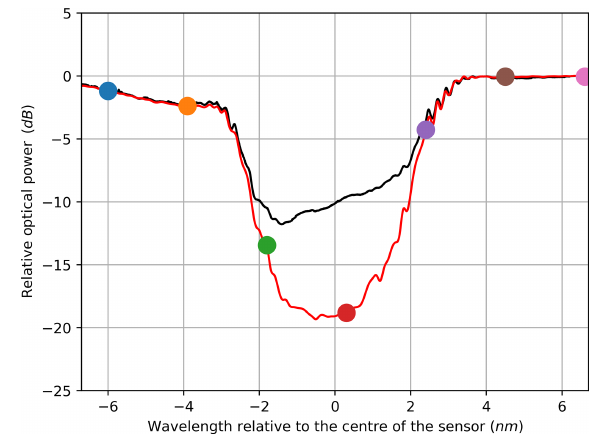
Figure 4. Electrically (red) vs. optically (black) derived filter char- acteristic of a cFBG in transmission configuration.